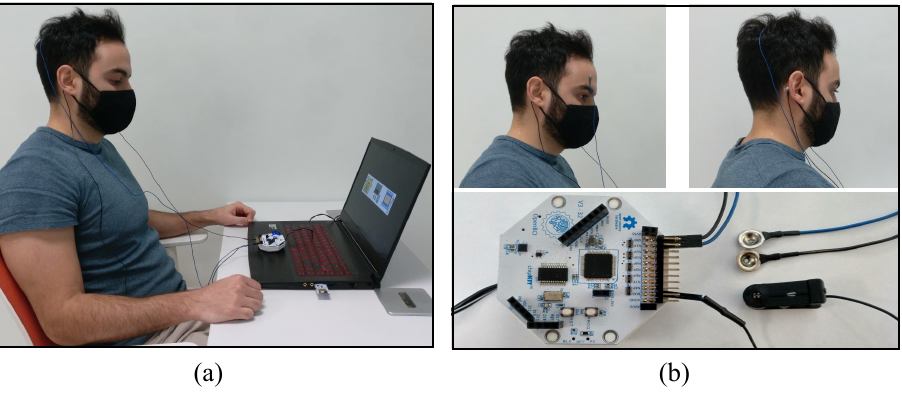
Figure 6. Recording session from one participant of the study, electrode placement for the ex- periments and recording device: ( a ) P300 recording session; ( b ) electrode locations for blinking experiments depicted on the upper left corner; electrode locations for P300 experiments depicted on the upper right corner, and the Cyton board employed for recording the data shown on the